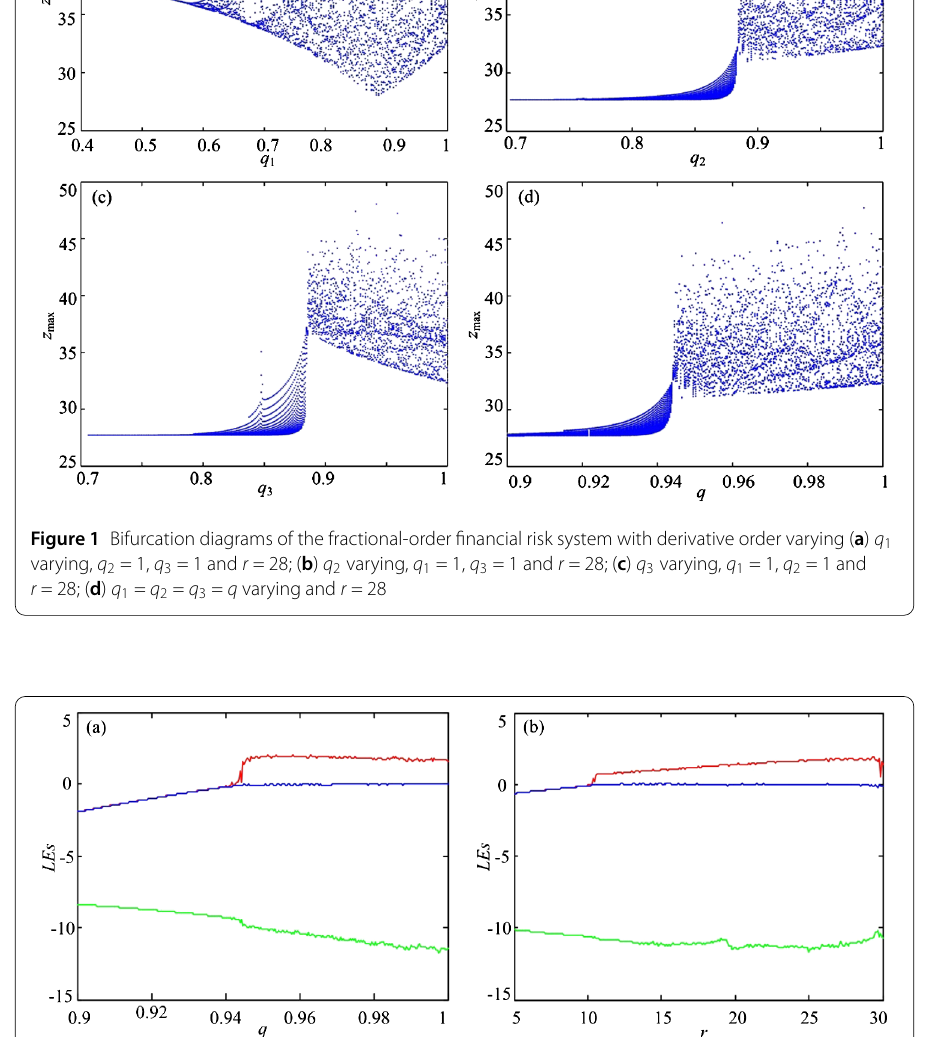
3 Adaptive fuzzy control for the fractional-order financial risk chaotic